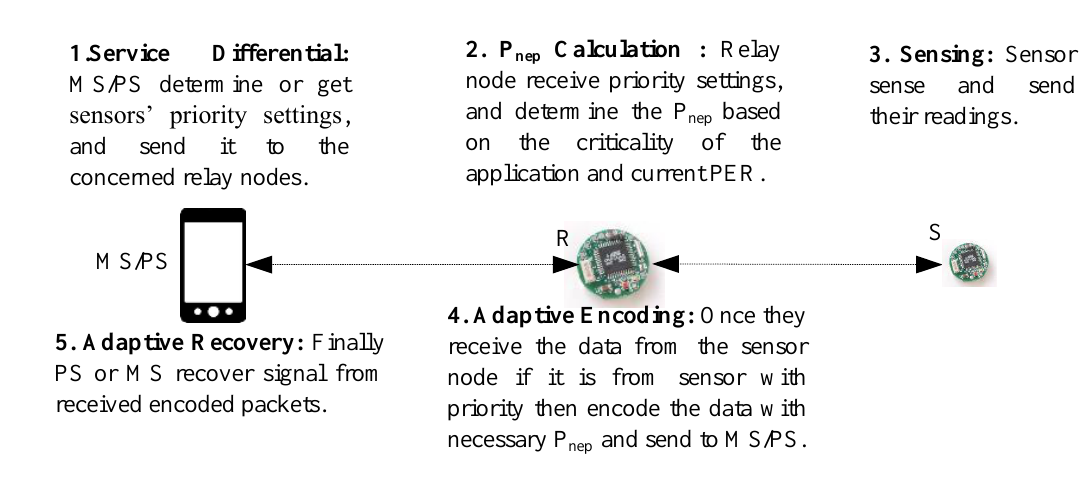
Figure 9. The working principle of the proposed error recovery